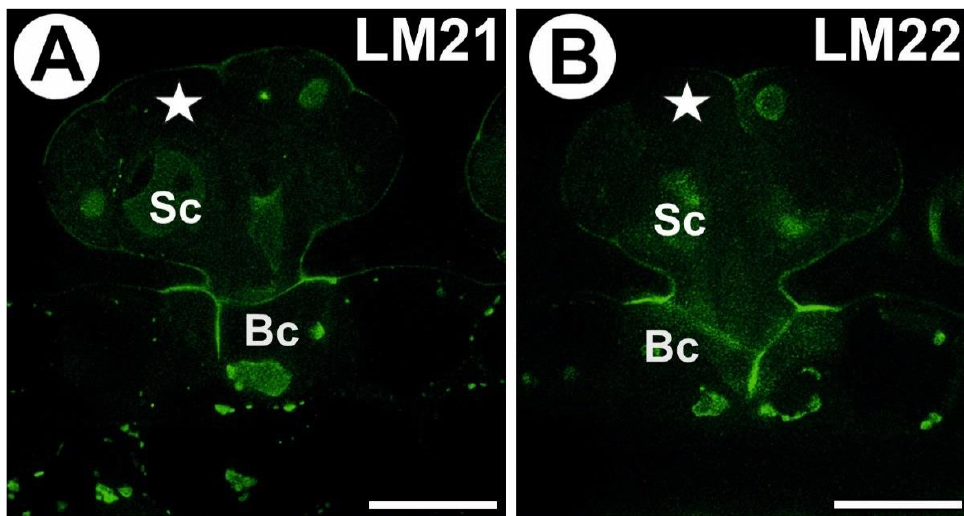
Figure 6. Heteromannan labeling in the Aldrovanda vesiculosa trap. ( A ) Heteromannan (labeled with LM21) detection in the gland, no signal in cell wall ingrowths; secretory cell (star), stalk cell (Sc), basal cell (Bc), bar 10 µm. ( B ) Heteromannan (labeled with LM22) detection in the gland, no signal in cell wall ingrowths; secretory cell (star), stalk cell (Sc), basal cell (Bc), bar 10 µm.